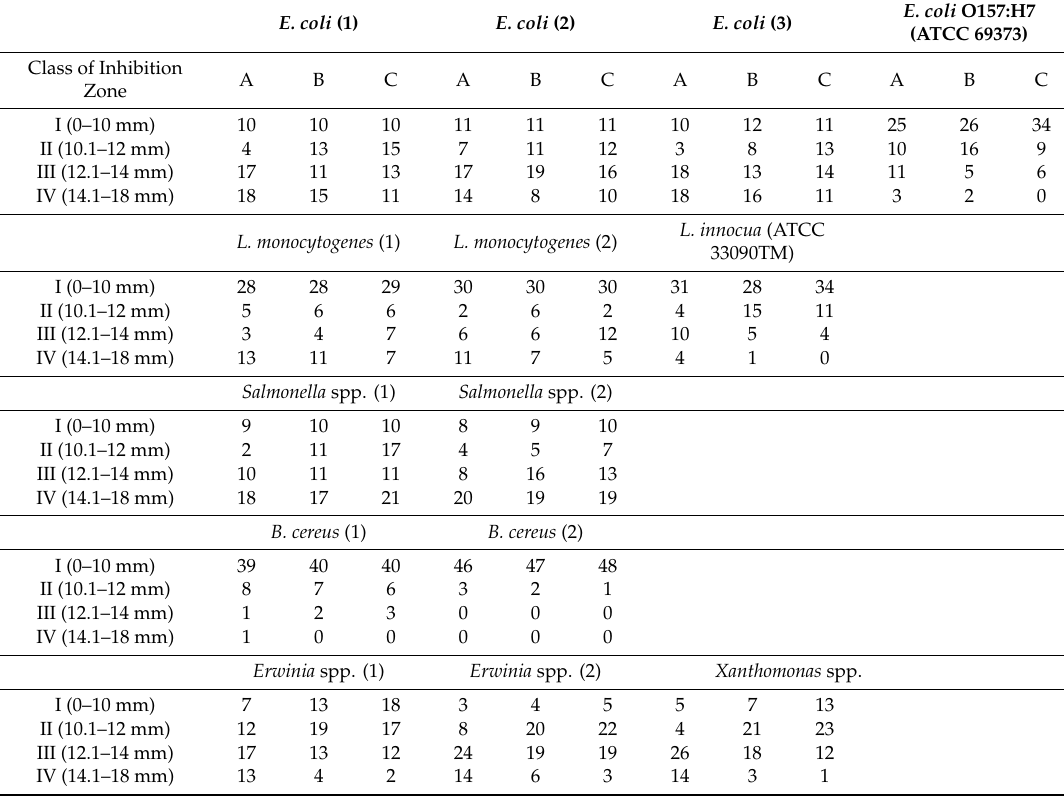
Table 3. Distribution of bacteriocin-producing LAB and Bifidobacterium , with respect to their class of inhibition zone against various